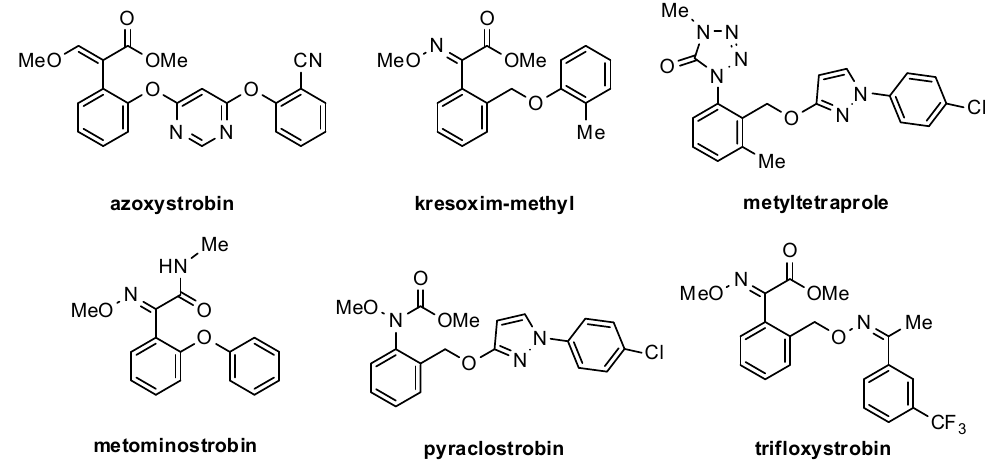
Figure 6. Validation set of marketed strobilurins and metyltetraprole.